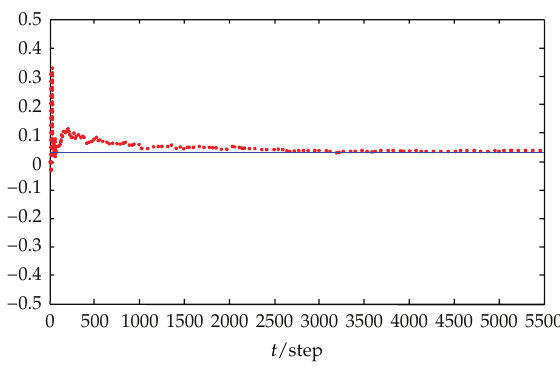
(cid:11) Q ξ 1 (cid:5) t (cid:6) .